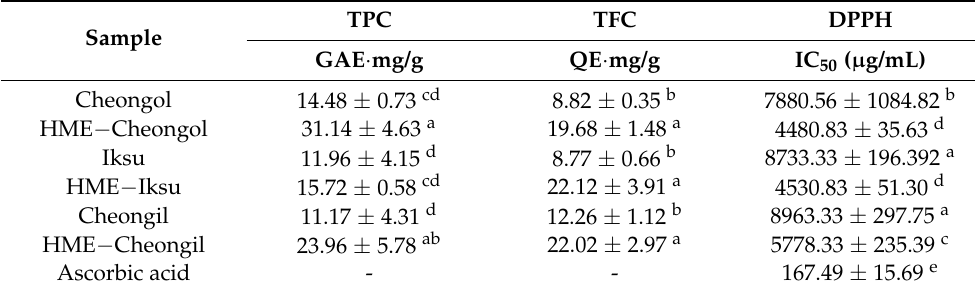
Table 3. Total phenolic content (TPC), total flavonoid content (TFC), and antioxidant activity by DPPH of mulberry leaf